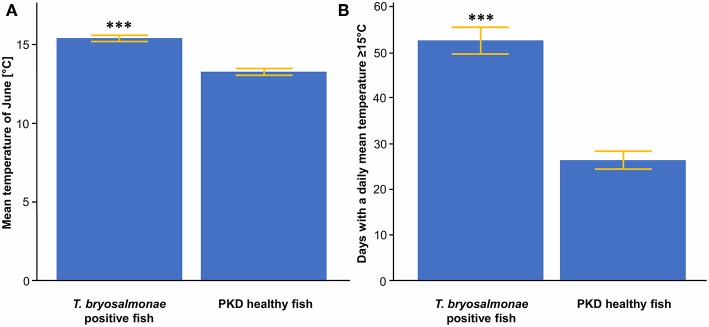
(A) Mean temperature of June between T. bryosalmonae infected and PKD healthy fish. (B) Number of days with a daily mean temperature ≥ 15°C between T. bryosalmonae infected and PKD healthy fish. Yellow lines indicate standard error, asterisks indicate levels of significance (t-Test), ***p < 0.001.